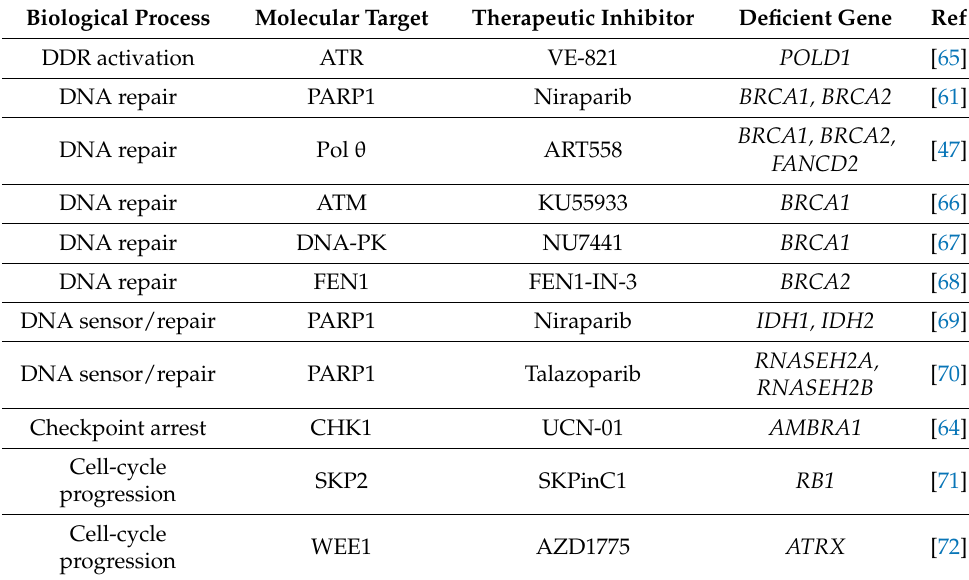
Table 2. Interactive gene-pairs for synthetic lethality targeting